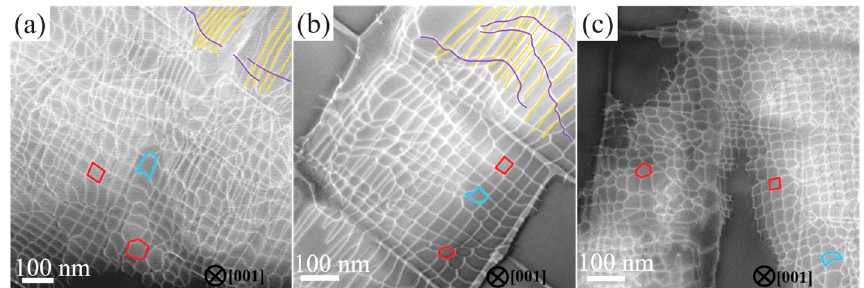
Figure 9. Dislocation networks under different strain amplitudes of an alloy at 980 °C: ( a ) Δ ε t /2 = 0.6%, ( b ) Δ ε t /2 = 0.8%, and ( c ) Δ ε t /2 = 1.0%. ( a ) ∆ ε t /2 = 0.6%, ( b ) ∆ ε t /2 = 0.8%, and ( c ) ∆ ε t /2 =